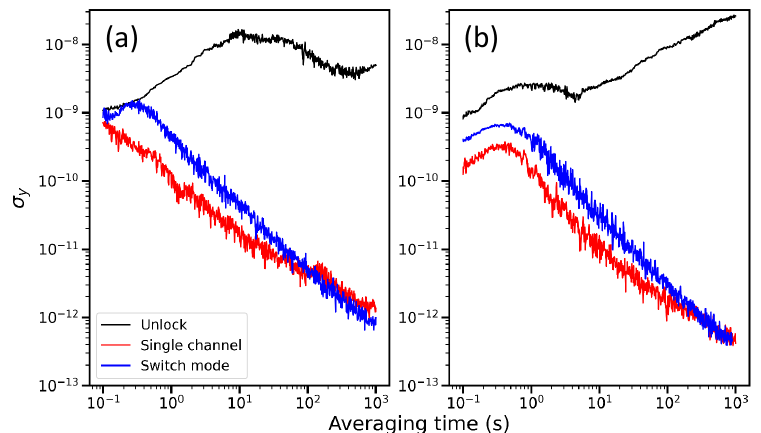
Figure 2. ( a ) Allan deviation of laser frequency when external cavity diode laser (ECDL) 1 is unlocked (black), locked with single wavelength meter channel (red), locked at switch mode with two channels (blue). Wavelengths of ECDL 1 and 2 are stabilized simultaneously in the switch mode. ( b ) Measurement result of ECDL 2. Legend is same as that of ( a ).